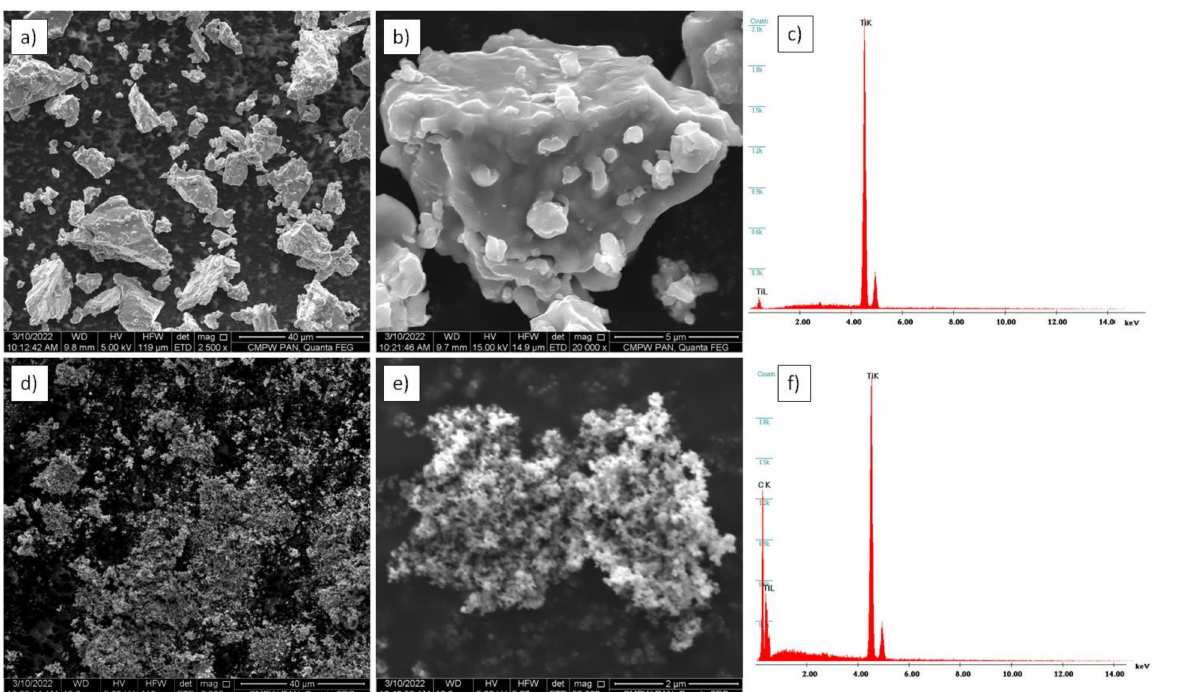
Figure 1. Morphology of initial powder: ( a , b ) titanium powder microstructure; ( c ) titanium powder